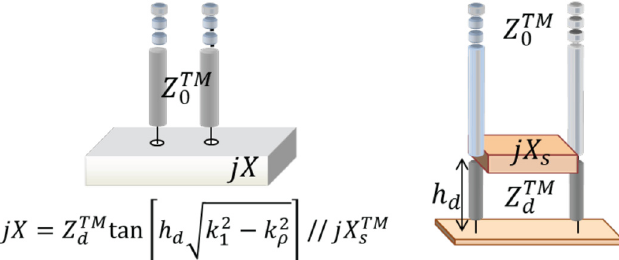
Fig. 1. Equivalent transmission line representation of a scalar metasurface using an impenetrable IBC (left) and using a penetrable IBC (right). Only the TM transmission line case is shown for the sake